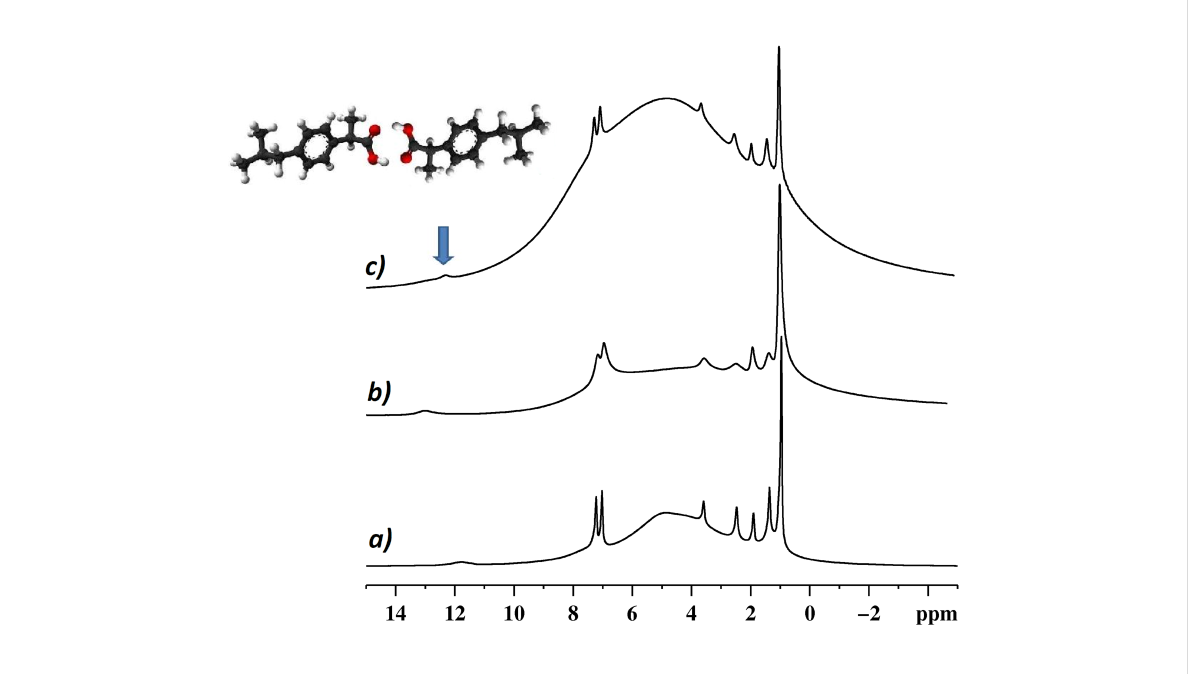
Figure 3: The effect of the spinning speed on the spectral features. 1 H MAS NMR spectra of a) CDNS(1:4)-IbuNa under conditions of fast spinning speed (40 kHz), b) CDNS(1:4)-IbuNa recorded at lower spinning speed (20 kHz), c) CDNS(1:8)-IbuNa recorded at 20 kHz spinning speed. The nota- tion CDNS-IbuNa indicates the original preparation, irrespective of the conversion of the sodium salt into the undissociated acid. The arrow indicates the peak assigned to the hydrogen bonded dimer, sketched in the inset.